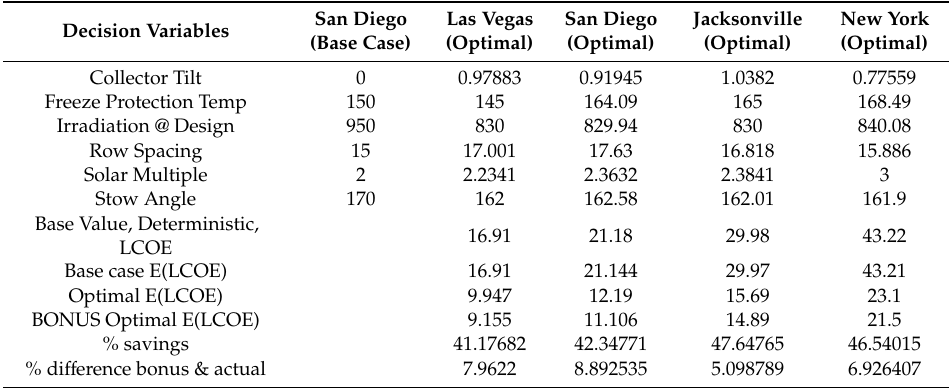
Table 3. Optimal values and cost savings for different locations with consideration of uncertainties. 403